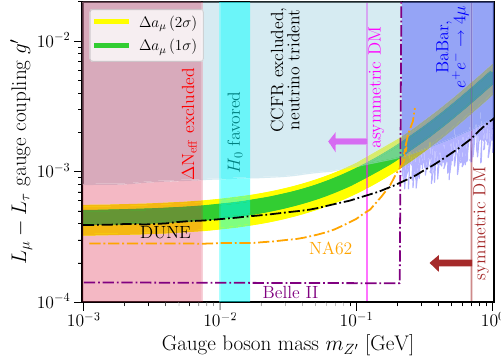
Fig. 3 Limits on the U ( 1 ) L μ − L τ gauge boson mass m Z (cid:3) and coupling g (cid:3) , assuming vanishing kinetic mixing. The green (yellow) region can resolvethe ( g − 2 ) μ anomaly[5]at1 σ (2 σ ).Thecyanregionameliorates the Hubble H 0 tension [114]. The other shaded regions are excluded by N eff [115,116], BaBar [117], and neutrino trident production in CCFR [40,118]. The dashed lines show the expected sensitivities of Belle-II (with 10 ab − 1 ) [119], DUNE [120,121] and NA62 (in K → μ + inv) [122]. Not shown are the sensitivities of M 3 [123] and NA64 μ [124, 125]. The vertical magenta (brown) solid line with arrow pointing to the left corresponds to the preferred region for asymmetric